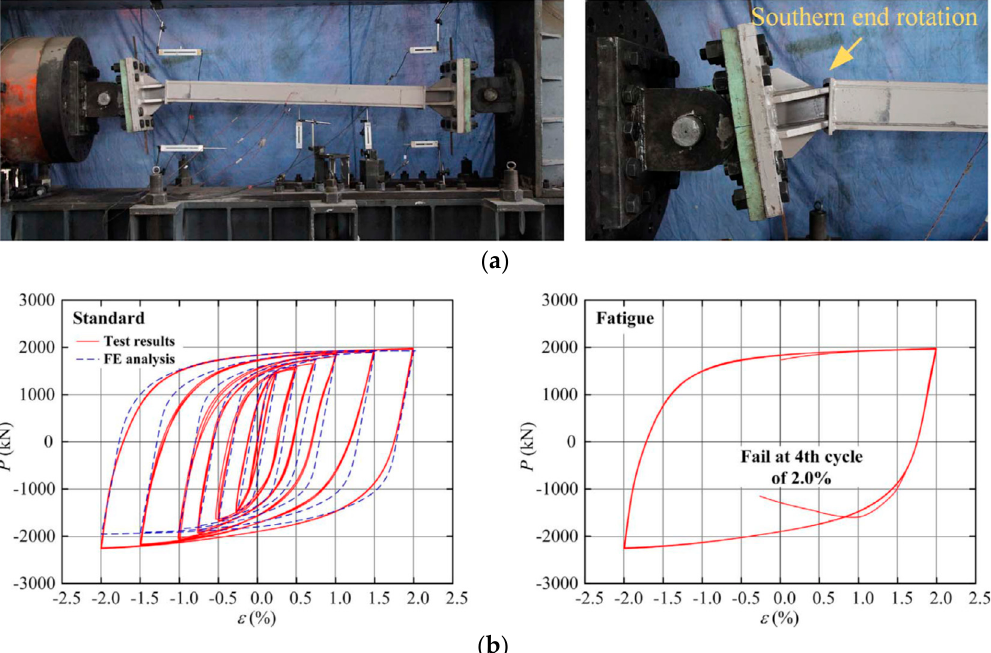
Figure 6. Verification of the FEM adopted in this study using the experimental results of Zhu et al. [22] and Tong et al. [26]. ( a ) Observed performance of CS-BRB specimens. ( b ) Hysteretic responses were obtained from tests and FE analyses.